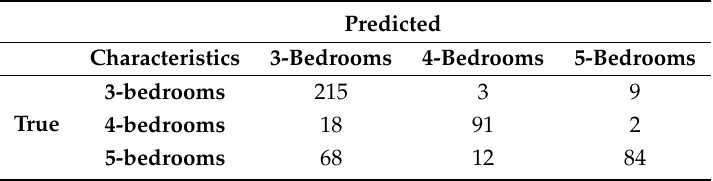
Figure 8. The model prediction of number of bedrooms. Table 8. The confusion matrix about the number of bedrooms.